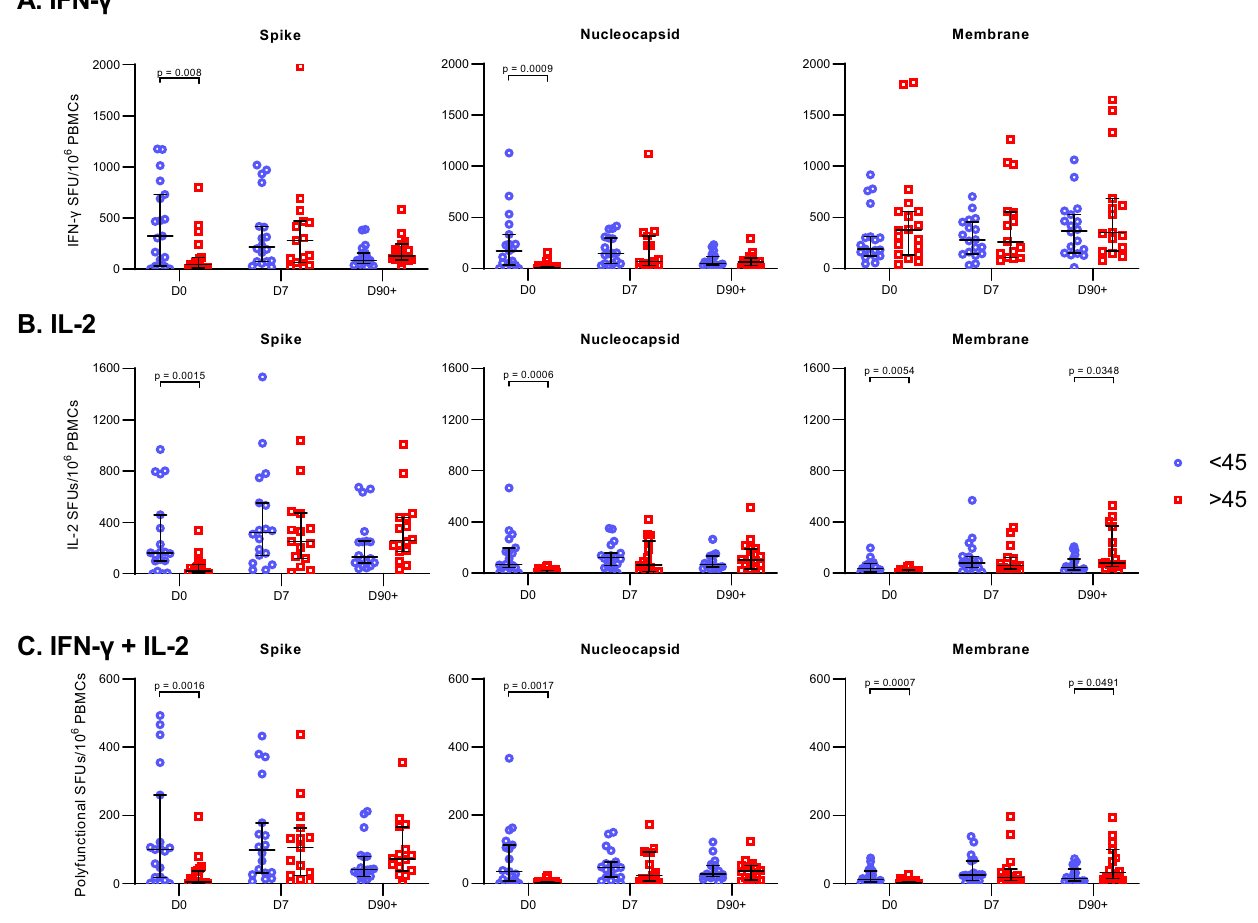
Fig. 4 | Differences in T cell responses between patients below and above the median age at day 0, day 7, and day 90+post-enrollment. A IFN- γ B IL-2 C Polyfunctional (IFN- γ +IL-2) T cell responses (as SFUs per 10 6 PBMCs) against structural SARS-CoV-2 protein peptide pools were compared between patients above and below the median age of the whole cohort (45years old). Each dot